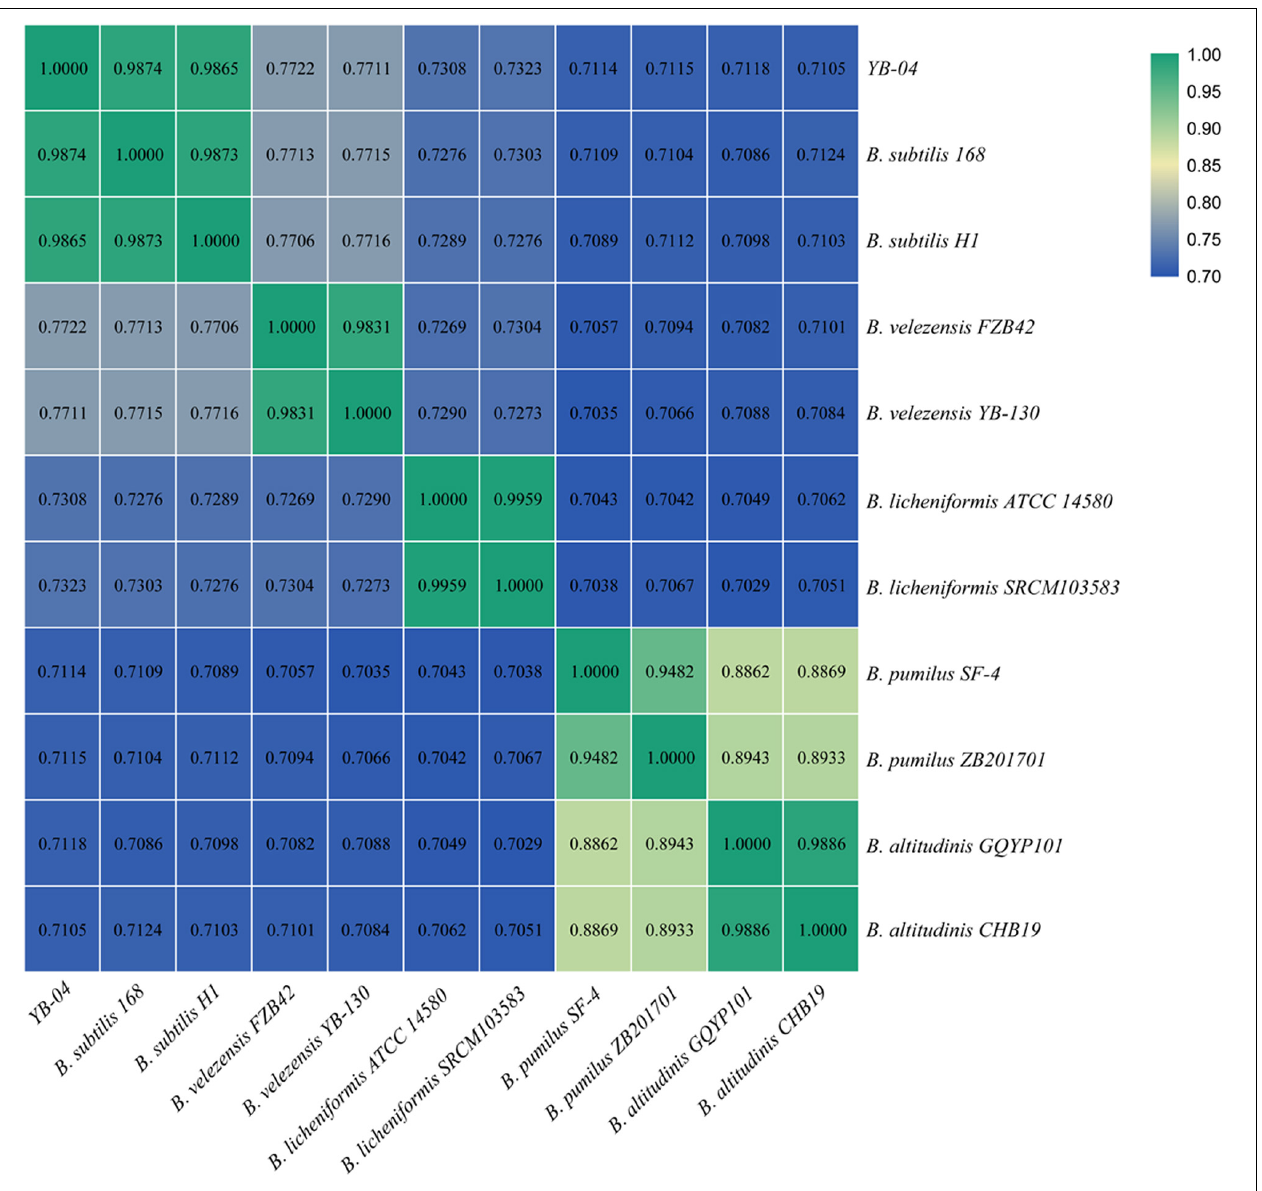
FIGURE 6 | ANI analysis of B. subtilis YB-04 and 10 other Bacillus